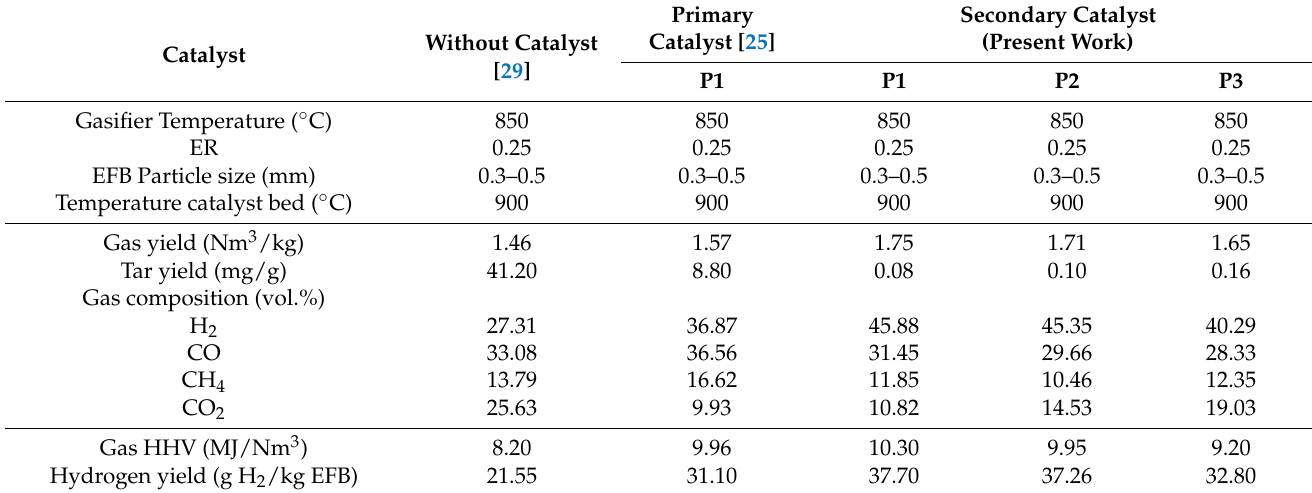
Table 2. Experimental results of empty fruit bunch (EFB) gasification reaction with and without Malaysian Dolomite catalysts.